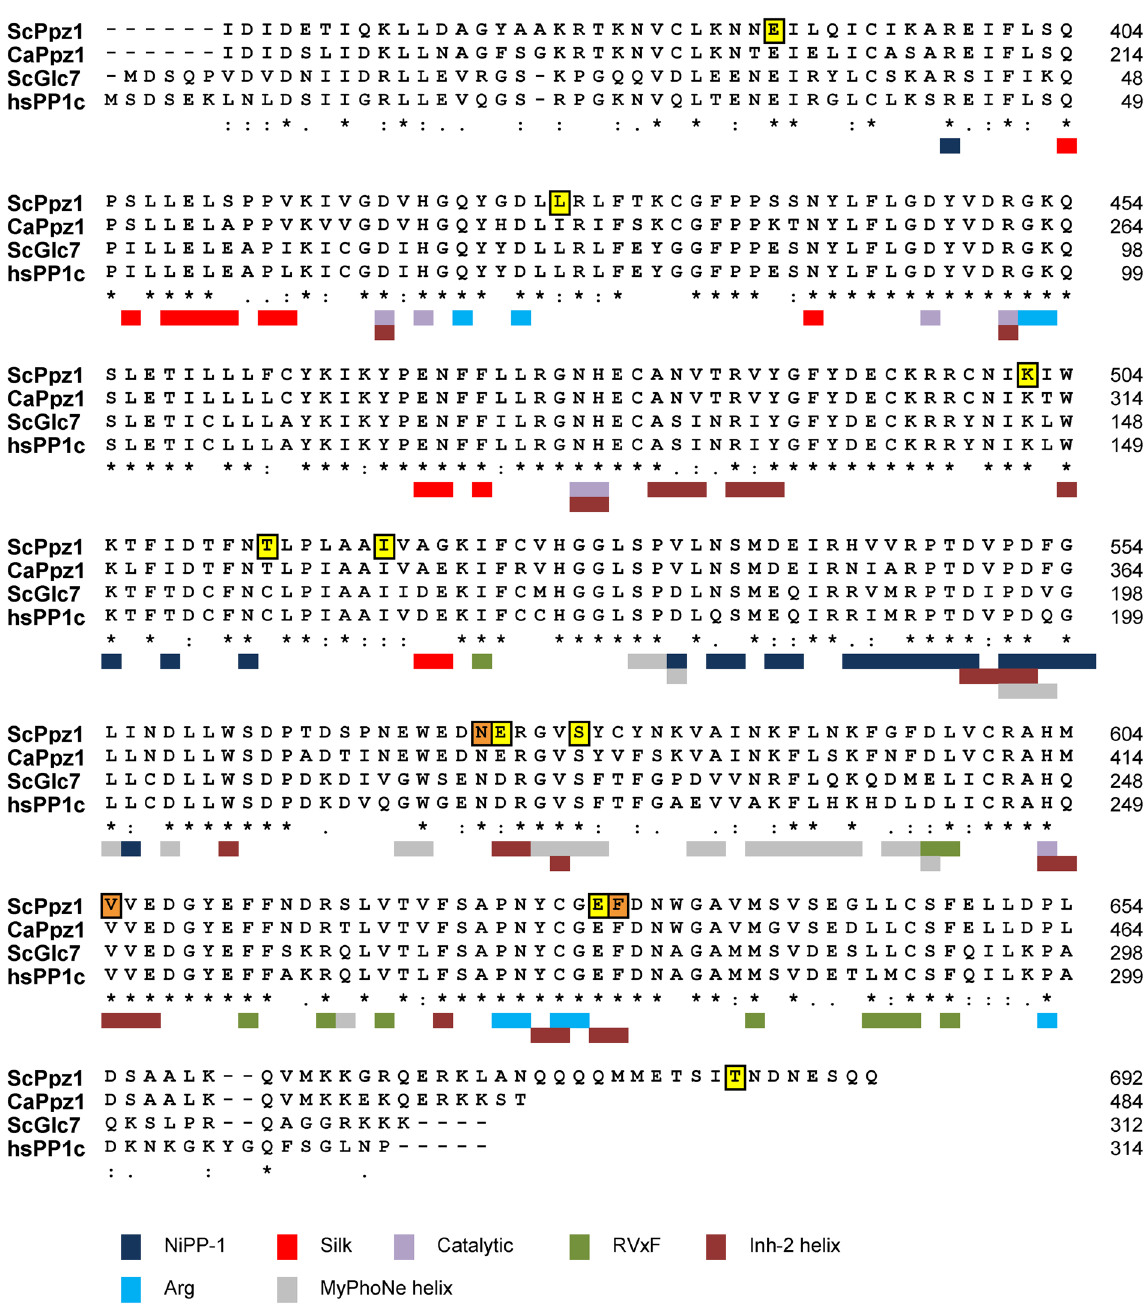
Figure 7. Alignment of the catalytic domains of Ppz1 from S. cerevisiae (ScPpz1) and C. albicans (CaPpz1), with the yeast (ScGlc7) and human (HsPP1c) catalytic subunit of type 1 protein phosphatase. The positions of the single mutations described in this work are denoted in yellow background, whereas the three relevant mutations found in clones 75, 121 and 129 are in orange. The positions of residues relevant for interaction with diverse motifs found in mammalian PP1c regulators (RVxF, SILK, NIPP-1, Arg, Inhibitor-2 helix), which are in some cases considerably conserved in Ppz1, or those forming the catalytic site, are indicated at the bottom of the sequences using a color code system. Numbering corresponds to the full length proteins. Inh-2,